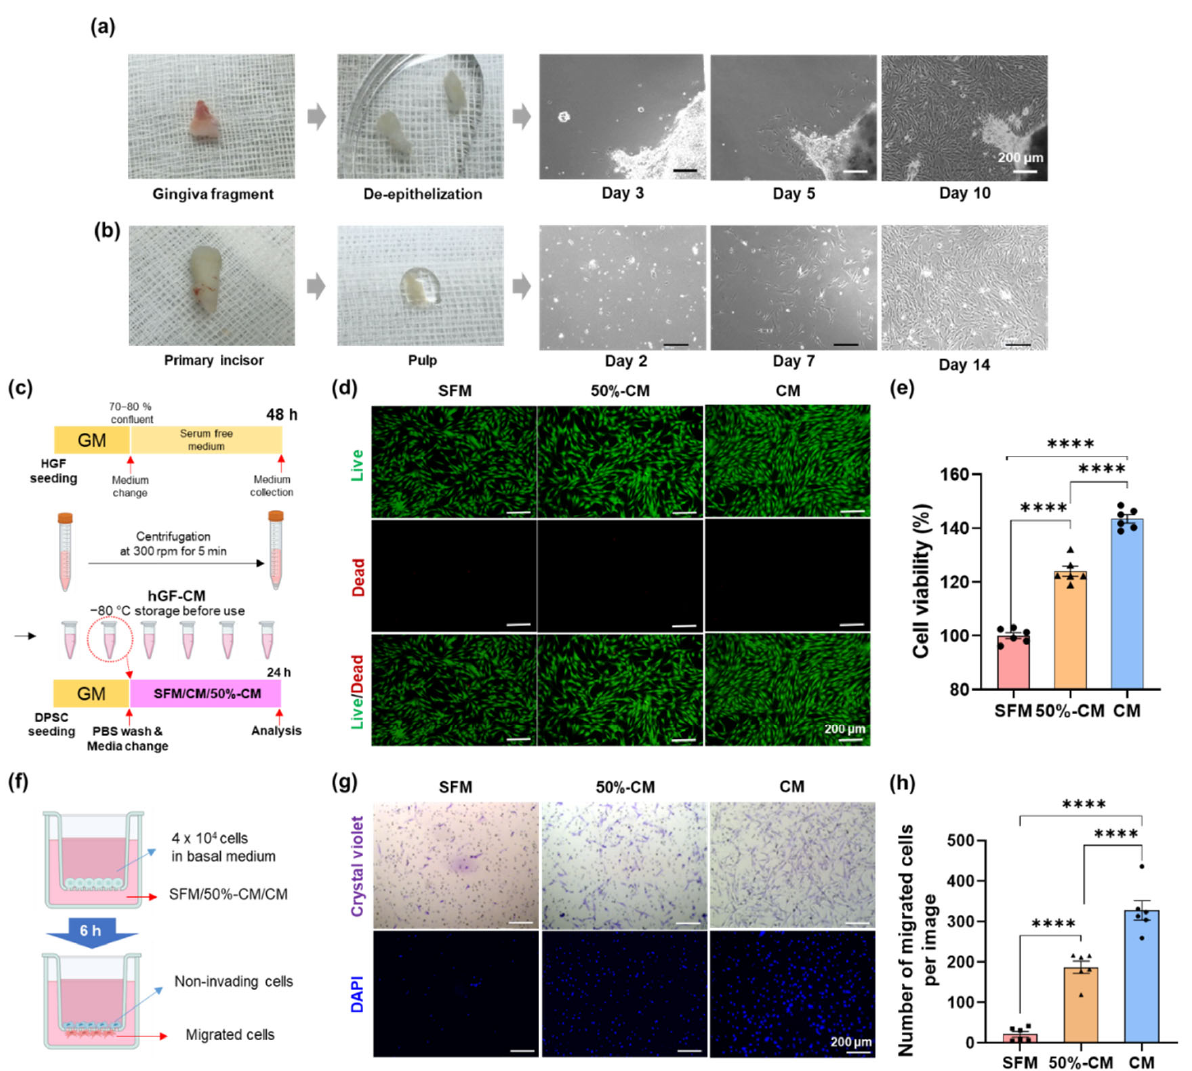
Figure 1. Effect of human gingival fibroblast-derived conditioned medium (hGF-CM) on the proliferation and migration of DPSCs. ( a , b ) Primary culture of hGF and hDPSC. ( a ) hGF started to spread out from de-epithelized gingiva masses at Days 3 − 5 after plating. It was highly proliferated and subcultured 10 − 14 days after seeding. ( b ) Primary DPSC isolated from pulp was observed at 16 − 24 h after seeding and then clustered on days 4 − 6. It was subcultured on Day 14 after seeding. Both hGF and hDPSC have a typical fibroblast-like appearance. ( c – e ) The effect of hGF-CM on proliferation. ( c ) Schematic images of the preparation for hGF-CM and the proliferation test on DPSCs to investigate the effect of hGF-CM. ( d ) Representative live/dead images of DPSCs 6 h after treatment with either hGF-CM, 50% hGF-CM, or SFM. ( e ) Quantified graphs of the viability of DPSCs measured by the CCK-8 assay. n = 6. ( f – h ) The effect of hGF-CM on migration. ( f ) Schematic image of the migration assay. A total of 4 × 10 4 cells in 100 µ L basal medium were seeded in the upper well, and the lower compartment contained 350 µ L hGF-CM, 50% hGF-CM, or SFM. ( g ) Representative images of migrated DPSCs to the lower side of the membrane stained with crystal violet and DAPI